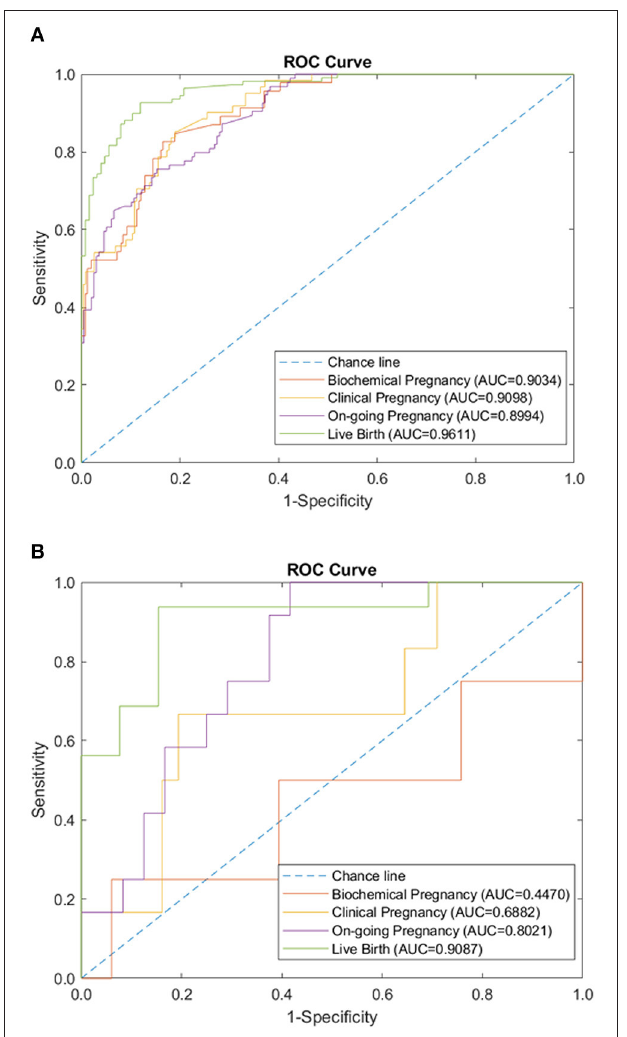
FIGURE 2 | Peripheral immunology panel performance of sparse coding in predicting pregnancy outcomes at different pregnancy periods. (A) ROC plot of the training data set. (B) ROC plot of the testing data